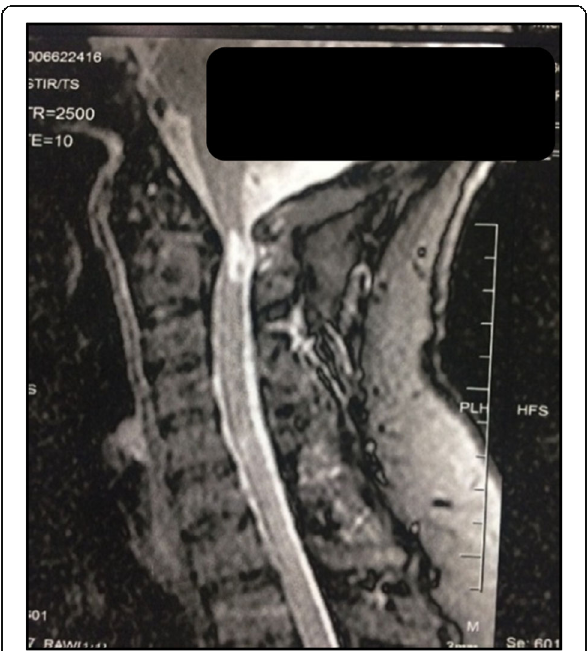
Fig. 4 Postoperative cervical spine AP and lateral views with C1 – C2 fixation